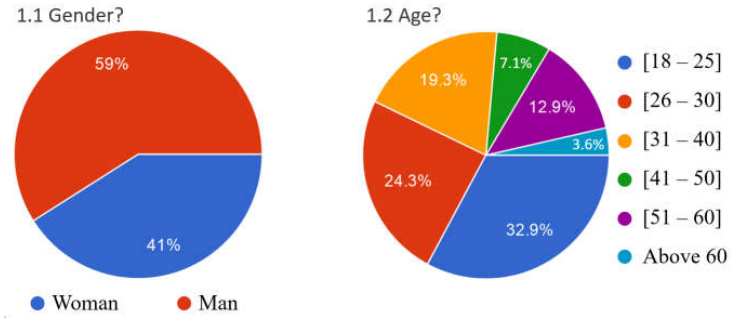
Figure 3. Participants’ profile (questions 1.1 and 1.2).